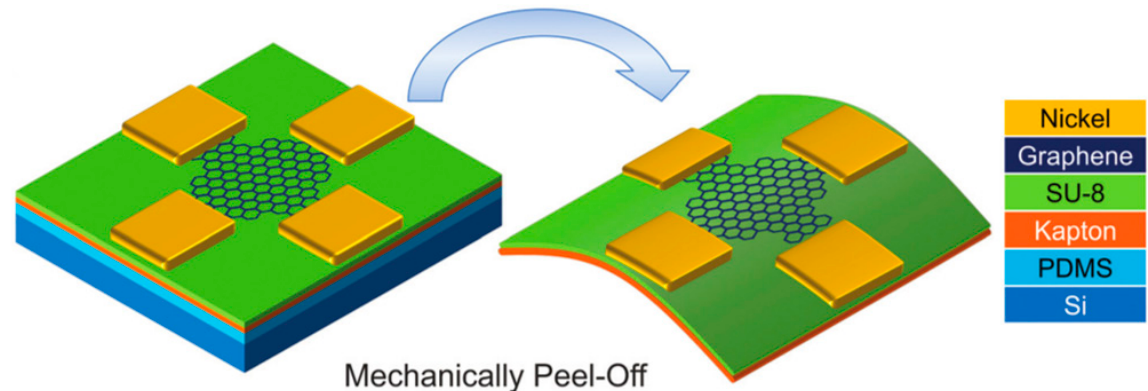
Figure 2. The device architecture of the flexible Hall sensor is based on graphene. Adapted with permission from Ref. [17]. Copyright 2016, copyright Royal Society of Chemistry.